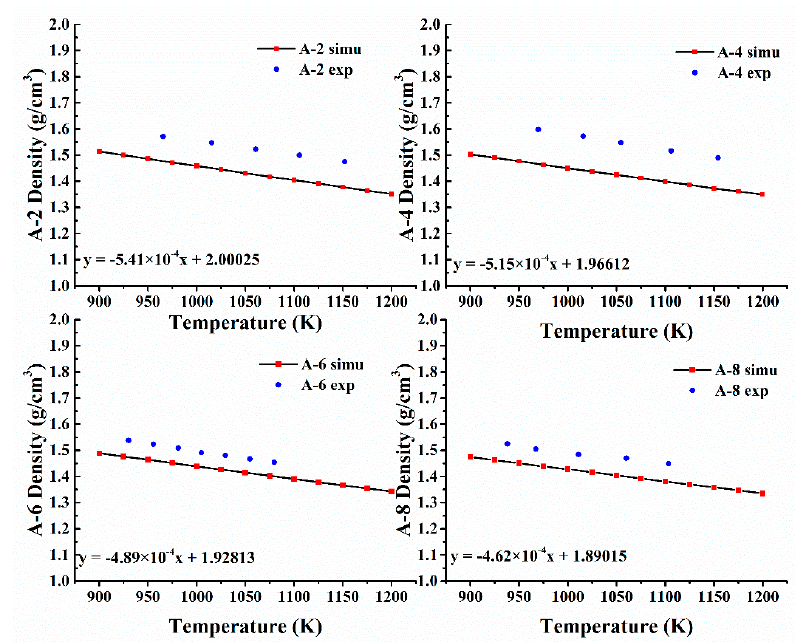
Figure 6. Comparison of simulated and experimental liquid densities with the linear fit formula of simulated density appending.